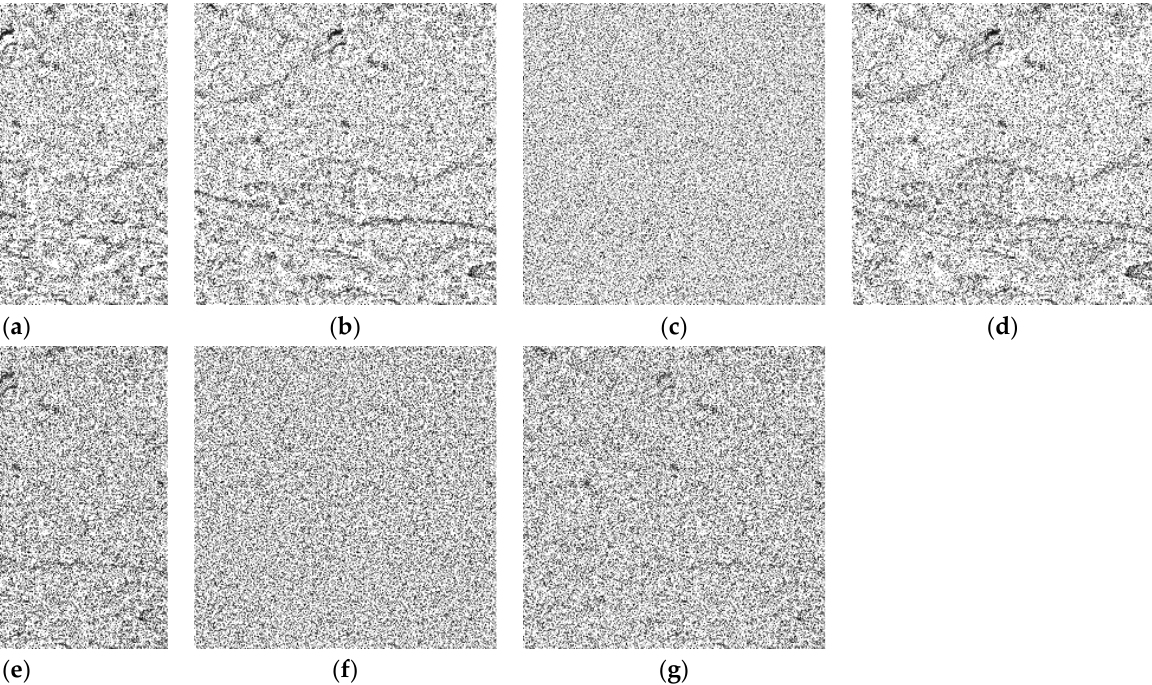
Figure 11. The results of all filters on S3 ( L = 1). The red box highlights the zoomed region of interest. ( a ) Clean image; ( b ) W-C; ( c ) PPB; ( d ) SAR-BM3D; ( e ) H-WNNM; ( f ) GNLM; ( g ) FANS; ( h ) Proposed method.